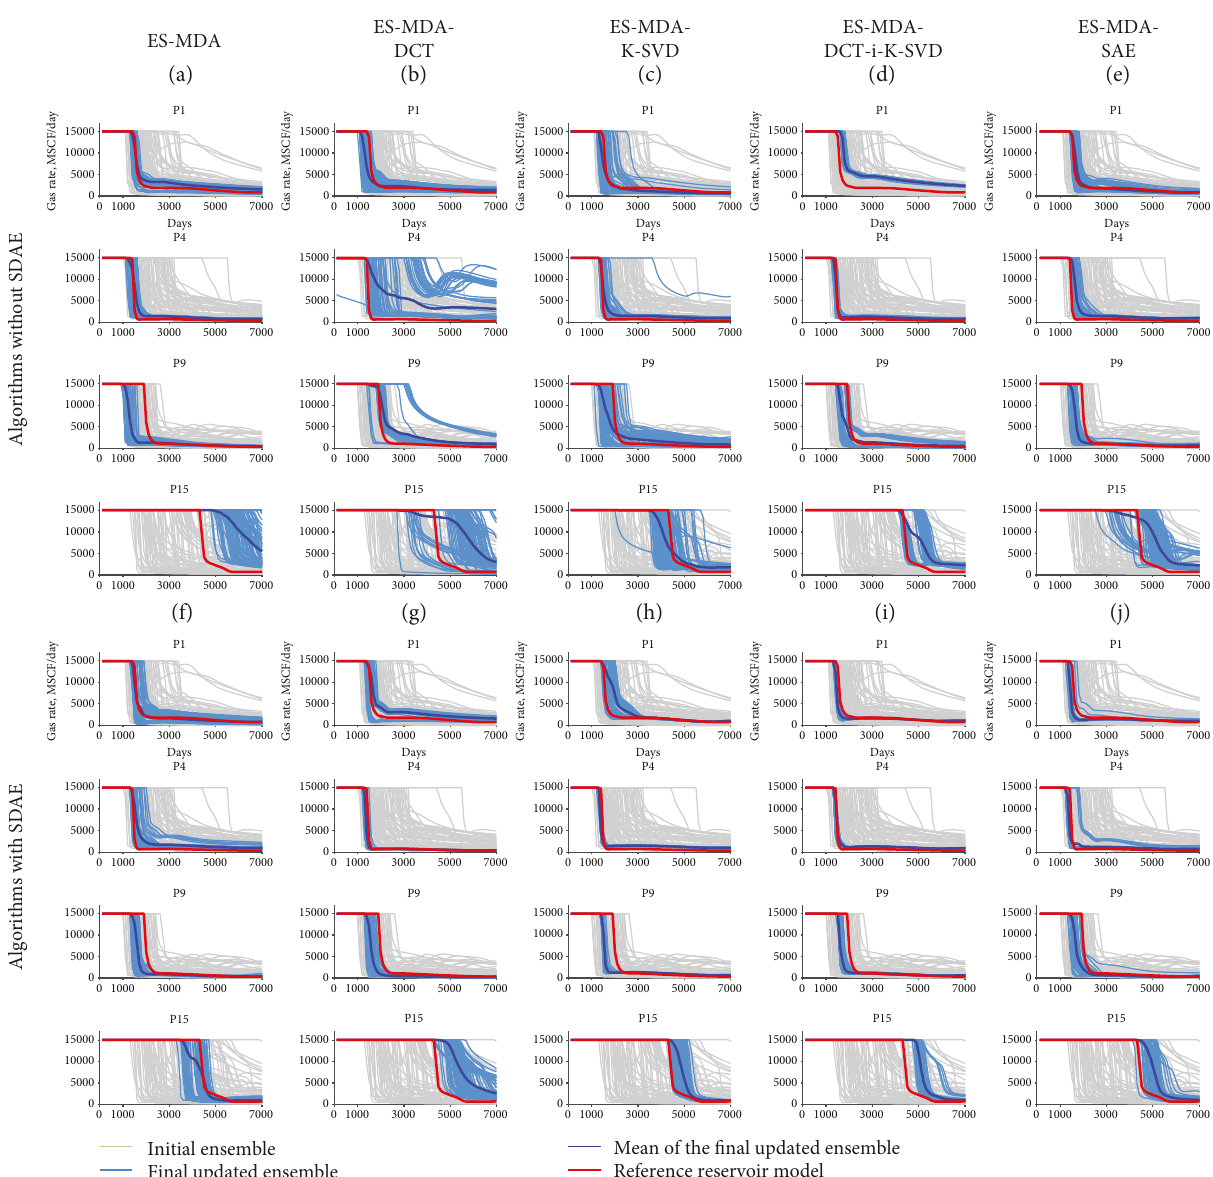
Figure 11: Pro fi les of gas production rate at the four wells (P1, P4, P9, and P15) obtained by executing the ten ES-MDA algorithms. The latter fi ve algorithms from (f) to (j) are the algorithms coupled with